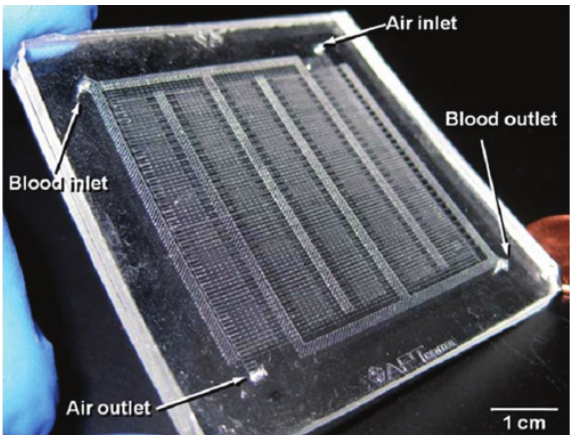
F 2: An example of a FIVD of an arti�cial lung (AL). A micro�uidic device mimicking physiological functions of the native lung. Air and blood inlets are shown and branched architecture of microchannels can be noted. Reproduced from Potkay et al. [9] with permission from e Royal Society of 𝜇𝜇